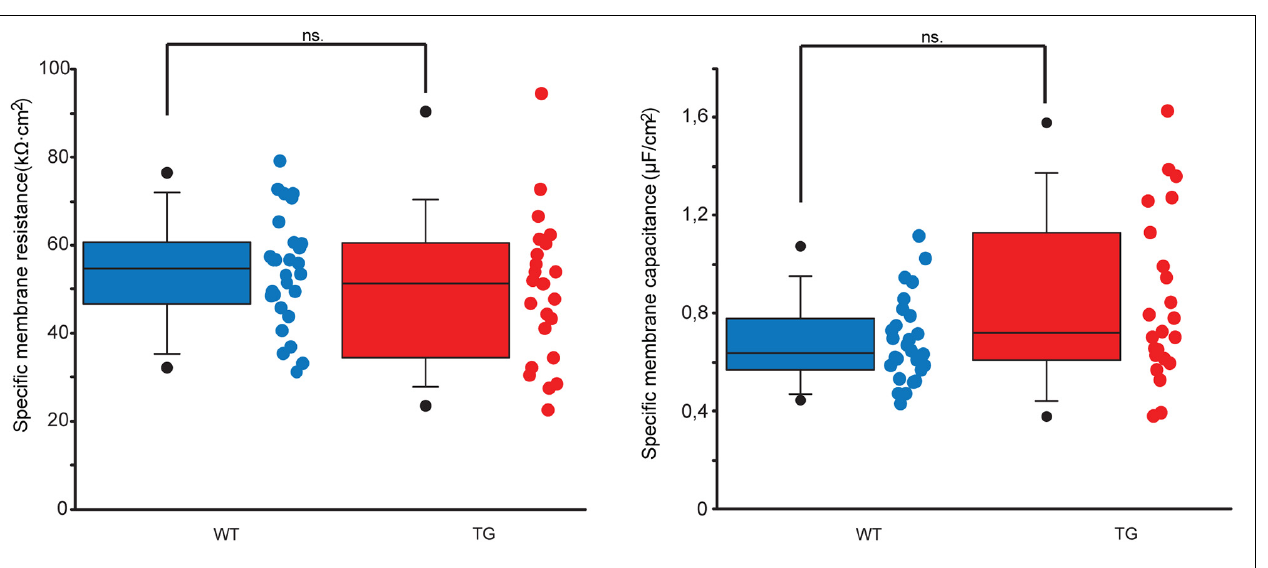
FIGURE 4 | Estimated specific membrane resistances and capacitances of WT and TG neurons. Dot and box plots comparing specific membrane resistances (left panel) and capacitances (right panel) of WT (blue) and TG (red) neurons. None of these membrane parameters get altered significantly by the mutant tau protein (Mann–Whitney test, p = 0.267 and p = 0.083 for resistances and capacitances, respectively). Lower and upper boundaries of the boxes indicate the 25th and 75th percentiles; a line within each box marks the median value; whiskers below and above the boxes show the 10th and 90th percentiles; lower and upper closed circles represent the 5th and 95th